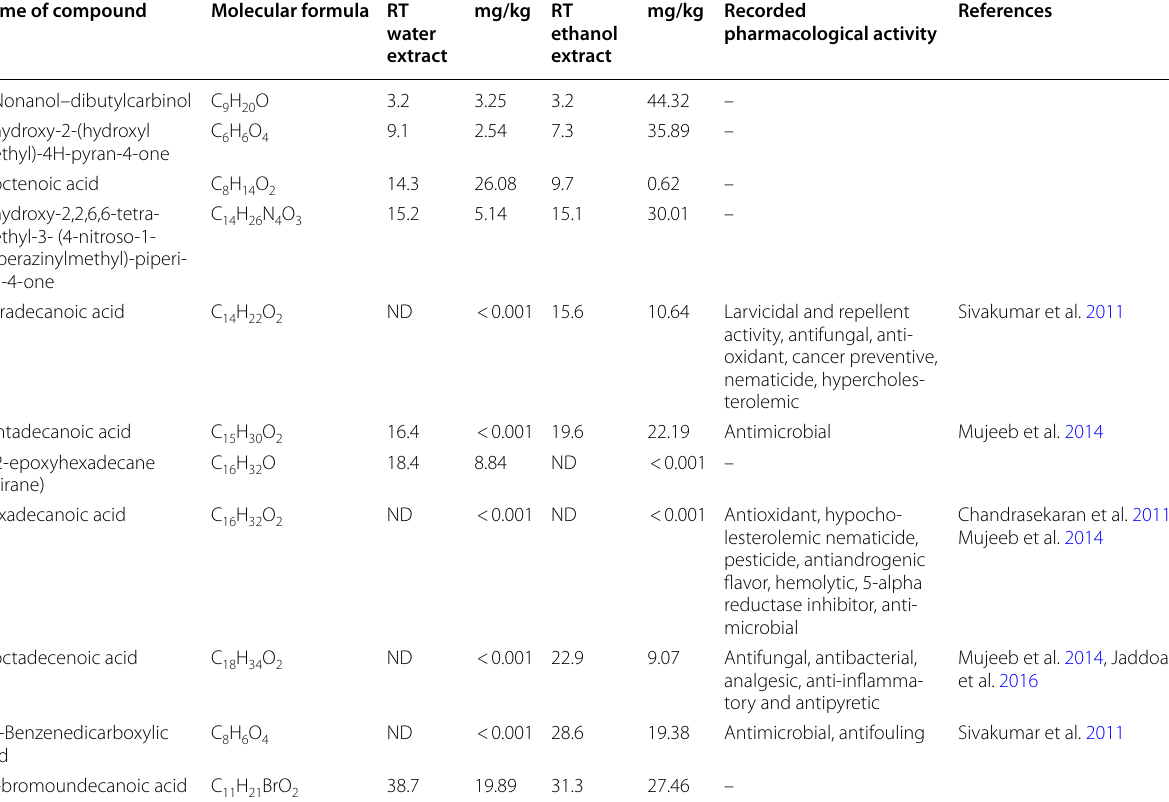
Table 4 Phytochemical components identified in aqueous and ethanol extracts of Moringa oleifera leaves by GC–MS analysis Name of